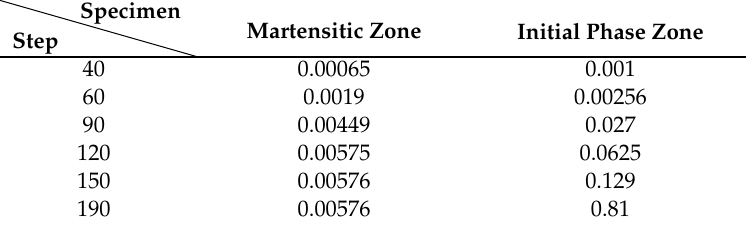
Table 2. Local maximum strain in di ff erent regions of uniaxial